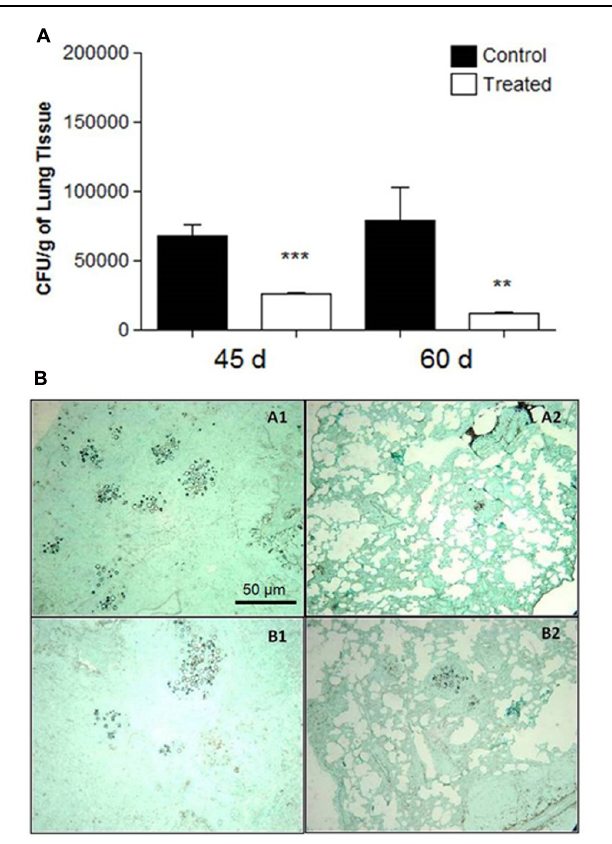
FIGURE 4 | (A) Colony forming units (CFU) in the lungs from BALB/c mice that received 1 mg of polyclonal antibodies against acidic glycolipids and 1 mg anti- BSA polyclonal antibodies (control) 30 days after infection with Pb18 and sacrificed after 45 and 60 days (therapeutic protocol). Significant values comparing the lungs of treated and control groups. ∗∗ p < 0.01, ∗∗∗ p < 0.0001. (B) Representative lung sections: therapeutic protocol. 3 days after i.t. infection, mice received polyclonal antibodies to acidic GSLs. Controls received polyclonal antibodies to BSA. Representative histopathological sections 45 days after i.t. infection: (A1) Lung from control mouse; (A2) Lung from treated mouse. After 60 days of i.t. infection: (B1) Control; (B2) Treated. Photographs of sections were taken at 100 ×